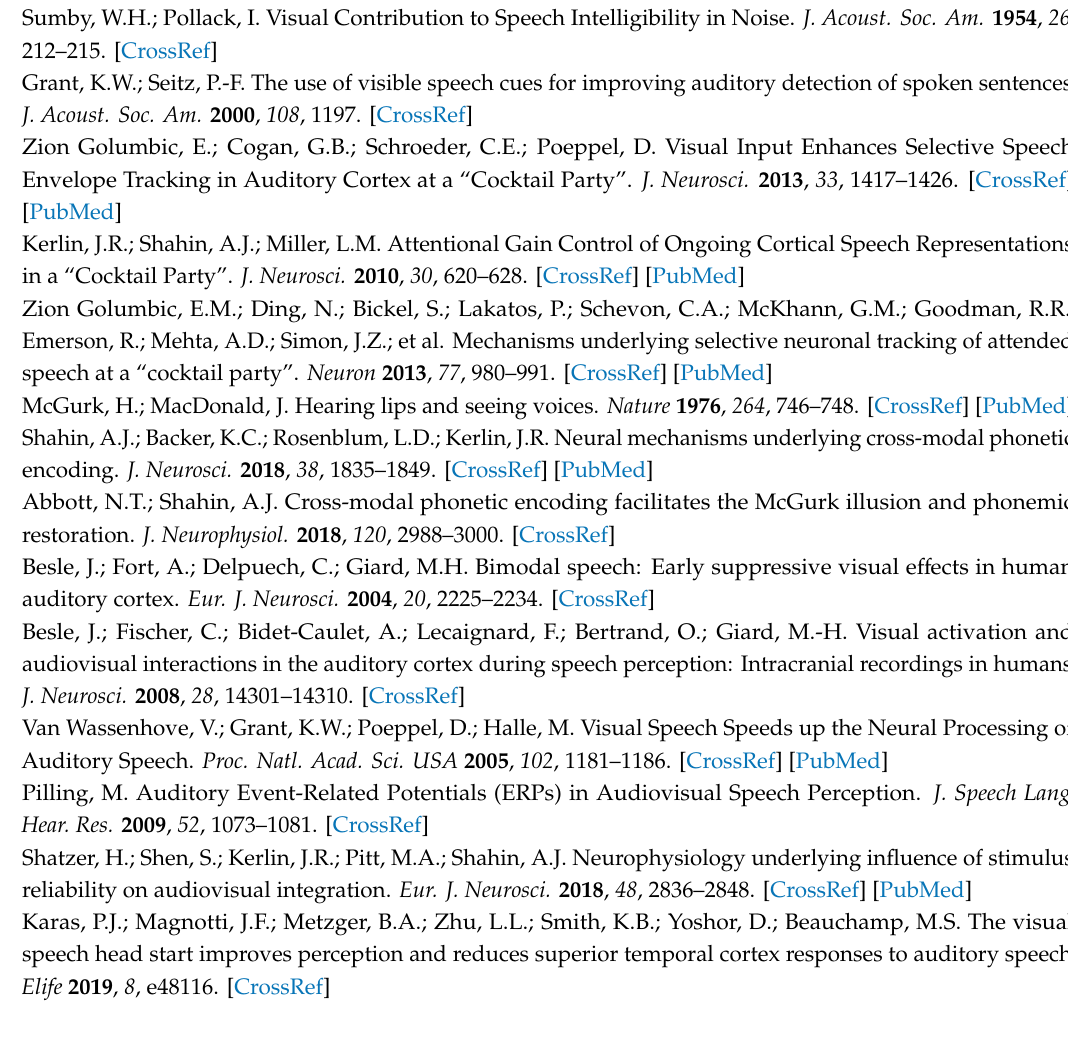
Table S1: Words used. The original data of the research are available online: https: // figshare.com / articles / dataset